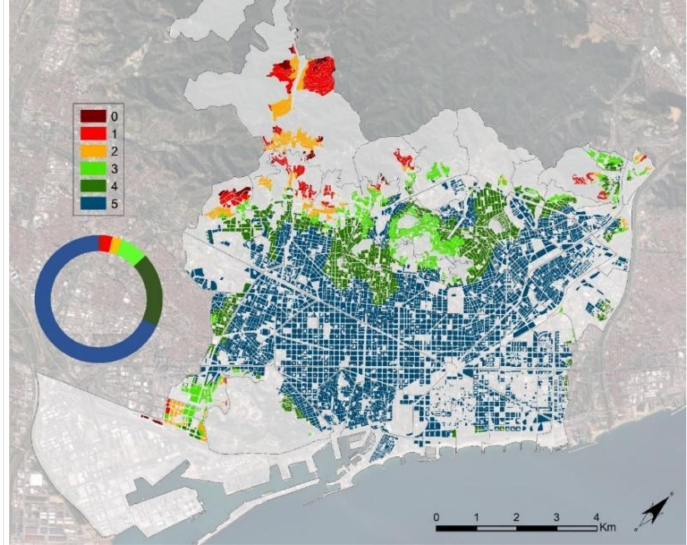
Figure 6. Public and non-motorized transport. Number of variables accessible simultaneously from each of the parcels. Source: own elaboration based on data from Open Data BCN [42] and the 1: 5000 Orthophoto from ICGC, used under a CC BY 4.0 license